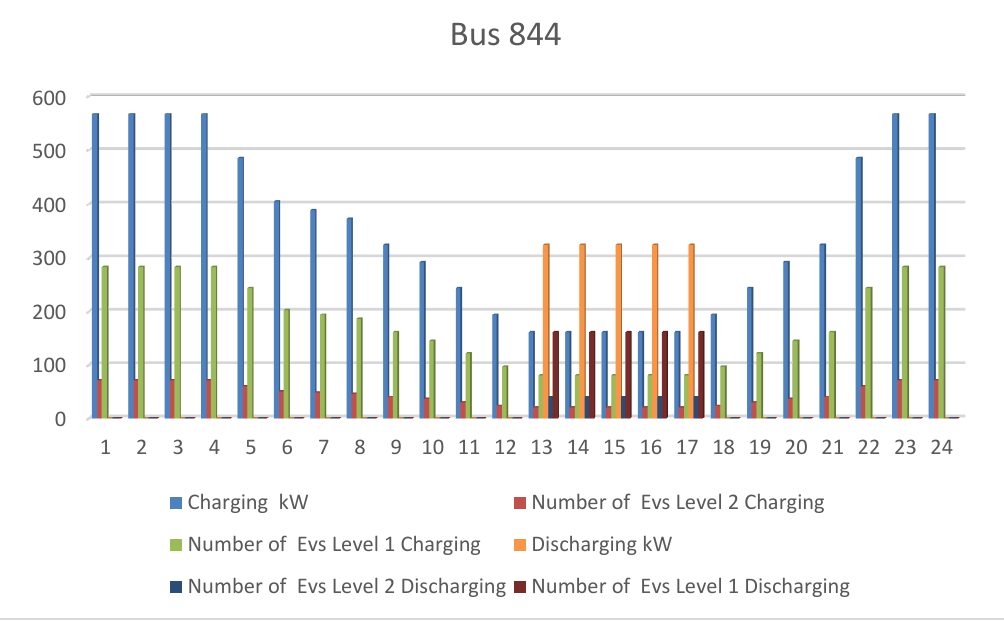
Figure 14 . Case 4 Additional Charging/Discharging Load and Number of EVs on Bus 844. Figure 14. Case 4 Additional Charging/Discharging Load and Number of EVs on Bus